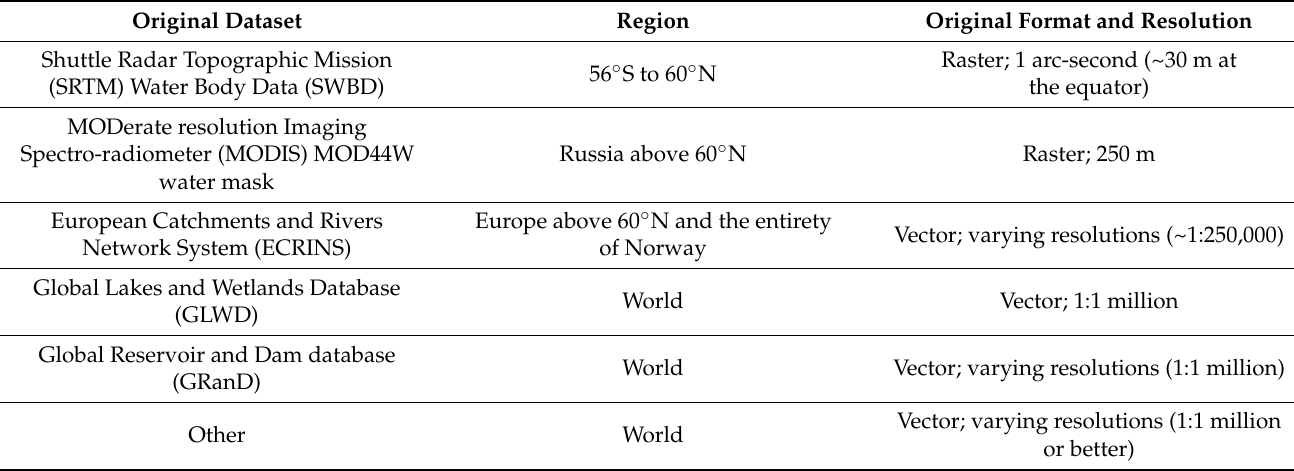
Table 1. Lake datasets references for HydroLAKES